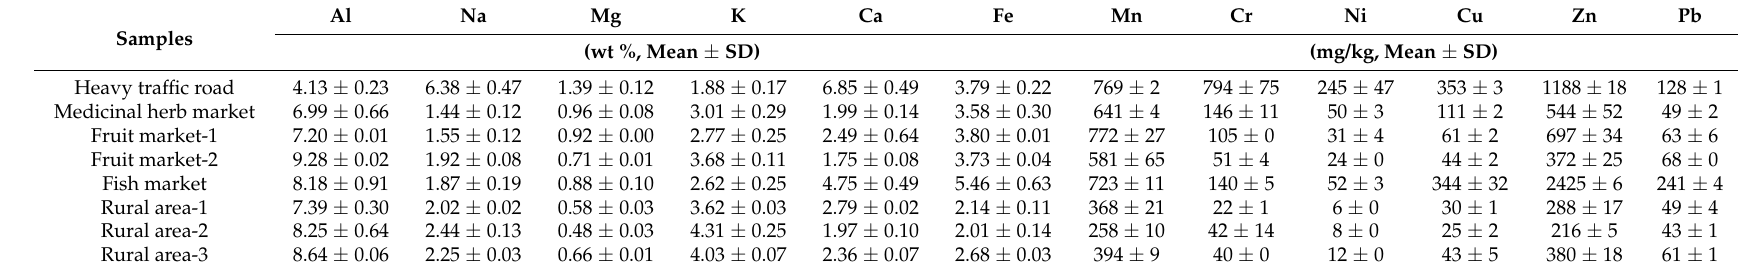
Table 1. Total elemental concentrations in street dust samples collected from a heavy traffic road, marketplaces and rural areas.